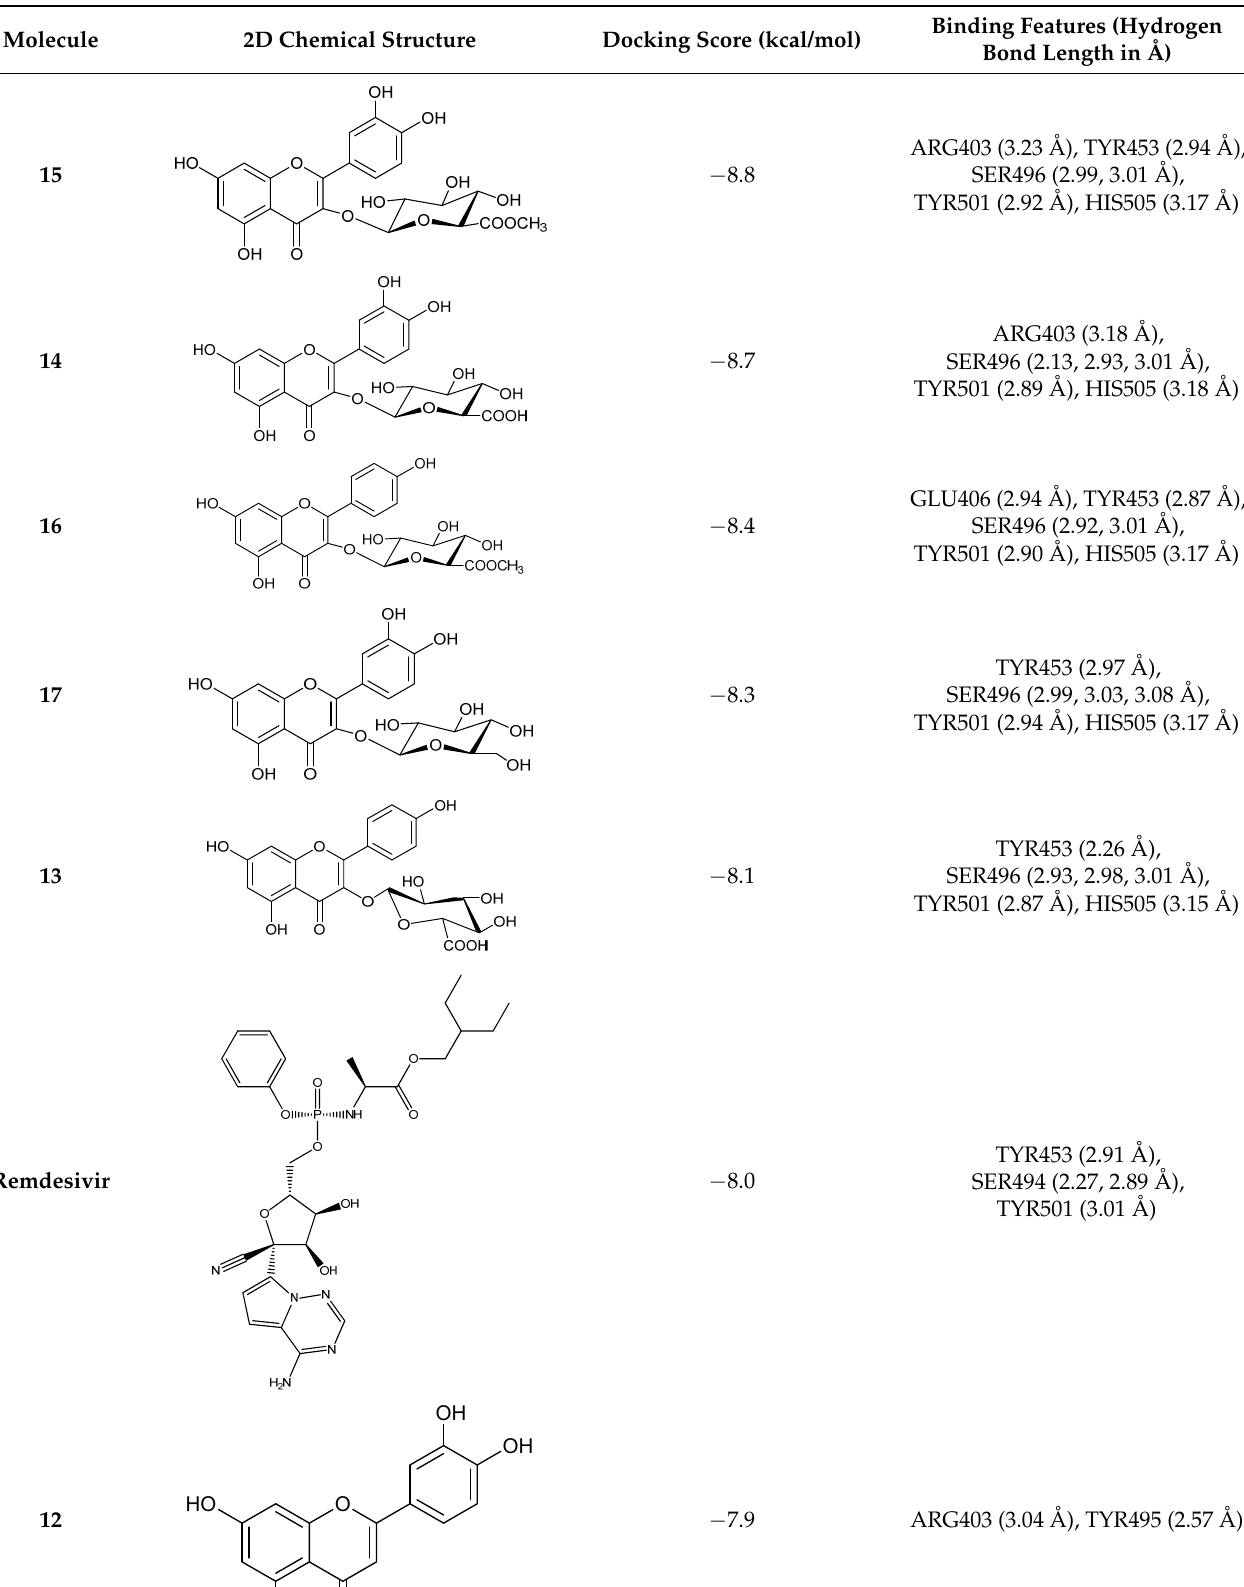
Table 1. Docking scores (in kcal/mol) and binding features for best six compounds and remdesivir against Omicron.